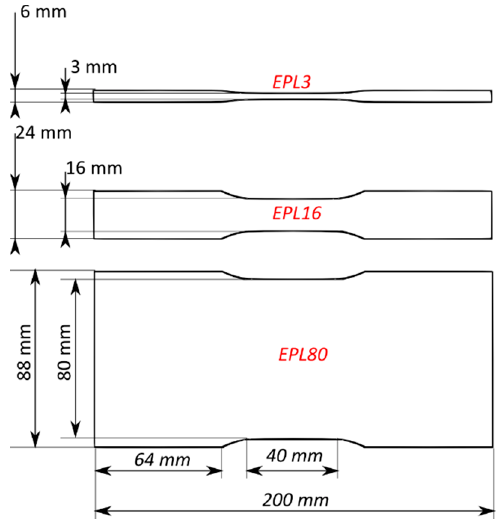
Figure 1. The three specimen geometries (EPL3; EPL16 and EPL80) used in all studies of this paper (thickness of the samples 3.7 mm).